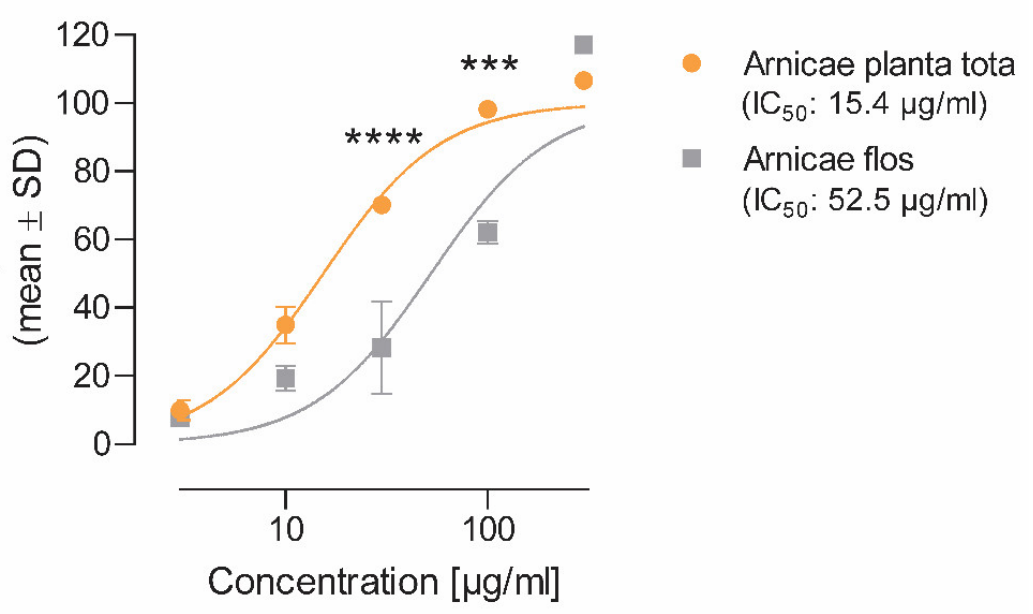
Figure 2. Inhibition of NF- κ B activity by Arnicae planta tota and Arnicae flos. The inhibitory effect of increasing concentrations of Arnicae planta tota and Arnicae flos on NF- κ B activity was evaluated using a NF- κ B reporter assay in human T lymphocytic Jurkat cells. Data are expressed as the percentage of reporter inhibition relative to vehicle, and the respective half-maximal inhibitory concentrations (IC 50 ) are indicated. Data are given as mean ± SD of two biological replicates from one representative experiment out of two independent experiments. Differences in NF- κ B activity inhibition between Arnicae flos and Arnicae planta tota for each extract concentration were tested using a two-way ANOVA with Bonferroni’s correction for multiple comparisons (***, p < 0.001; ****, p < 0.0001). Positive control for NF- κ B inhibition and cytotoxicity controls are shown in Figure S2.